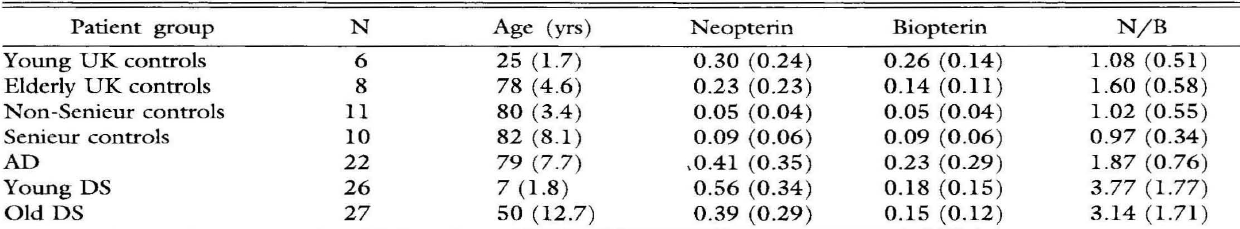
Table 1 The mean levels (with standard deviations in parentheses) of neopterin, biopterin (I-lmol mmol- j creatinine) and the Neopterin/Biopterin ratio in groups of control subjects and patients with Alzheimer's disease (AD) and Down's syndrome (DS) (*P<O.OS, **P<O.Ol, ***P<O.OOl ).